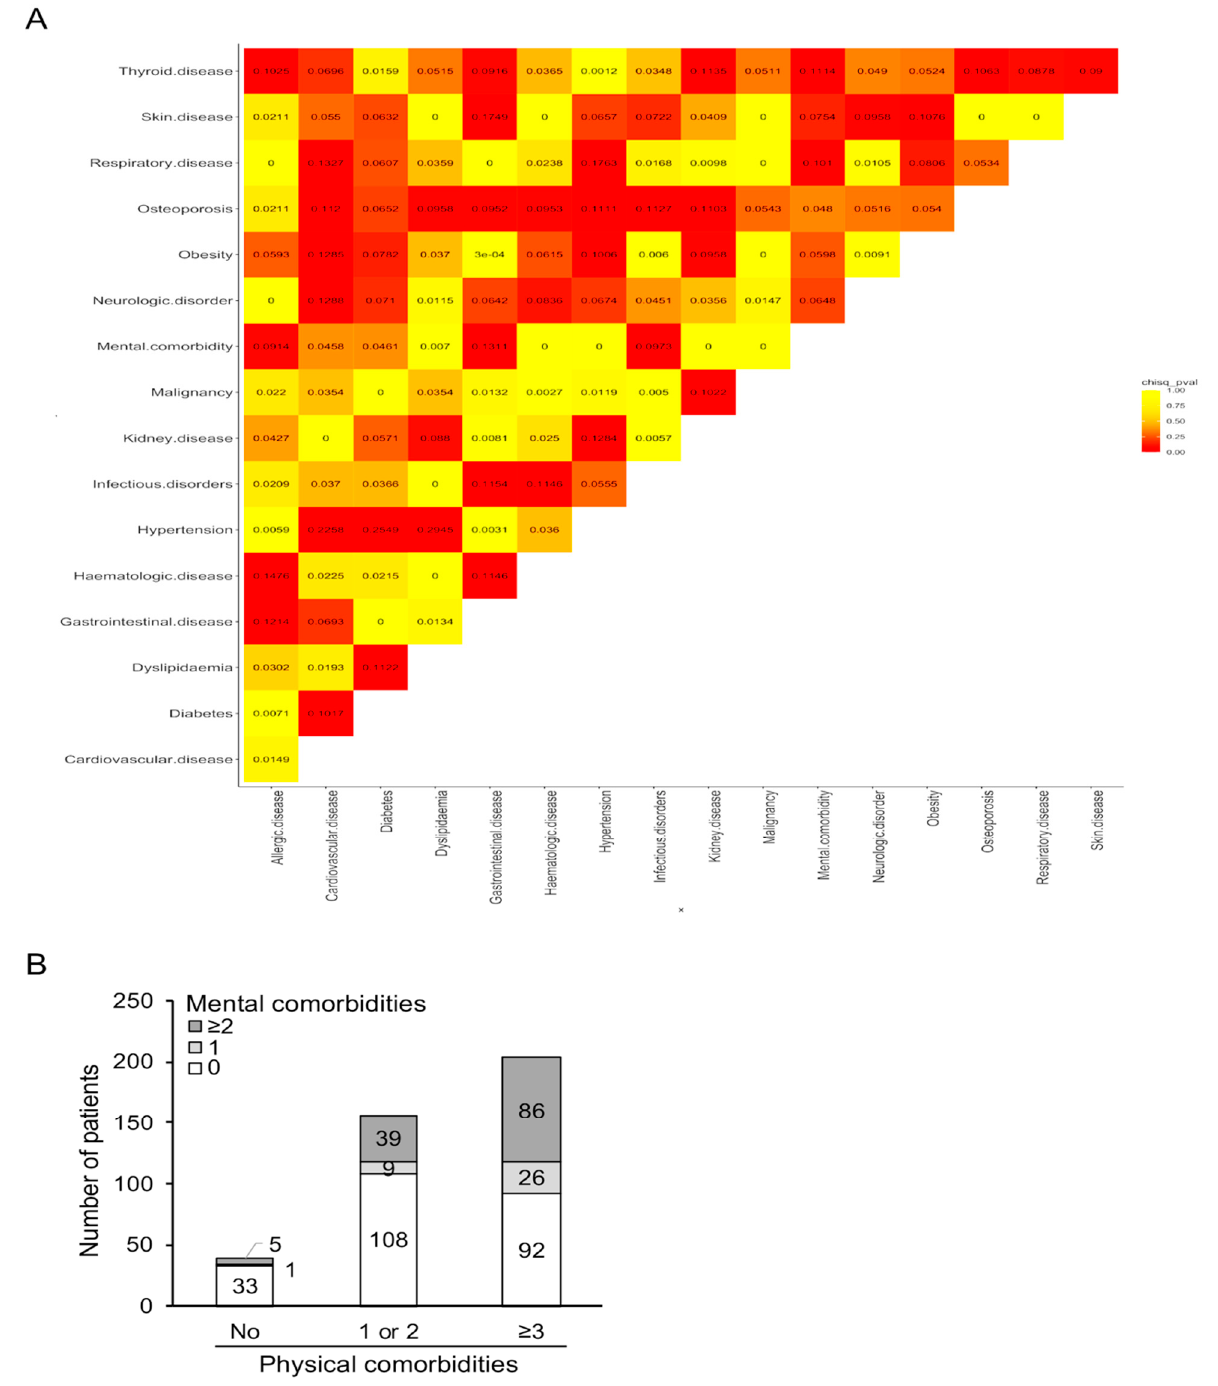
Figure 1. Co-segregation of comorbidities in patients with SLE at the community-based registry of Crete. ( A ) Correlation matrix of various comorbidities from diverse organs and domains. Numbers inside each box represents the Cramer’s V statistic estimated for each pair of comorbidities with values > 0.10 signifying robust correlation. Color intensity corresponds to the chi-squared p -value for each pairwise association. ( B ) SLE patients were categorized according to the number of physical (none, 1 or 2, ≥ 3) and mental (none, 1, ≥ 2) comorbidities as described in the main text. Y axis shows the number of patients with various combinations of physical and mental comorbid disorders.